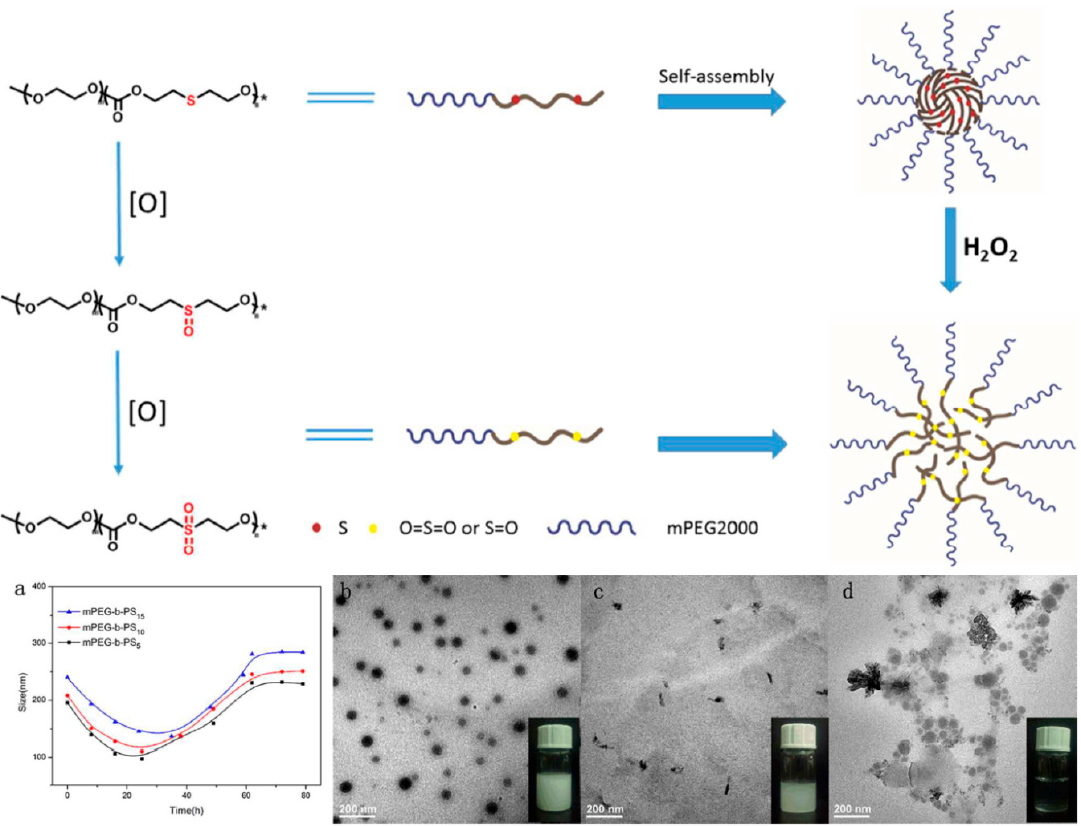
Figure 7. ( Top ) Schematic illustration of self-assembly of the PEGylated thioether-containing APC and its oxidation behaviors. ( Bottom ) The micelles size changes determined by DLS (a) and corresponding TEM images (b–d) at different oxidation times (0, 30 and 60 h, respectively) in the presence of H 2 O 2 at 37 °C. Reprinted with permission from ref [134]. Copyright 2018 Royal Society of Chemistry.